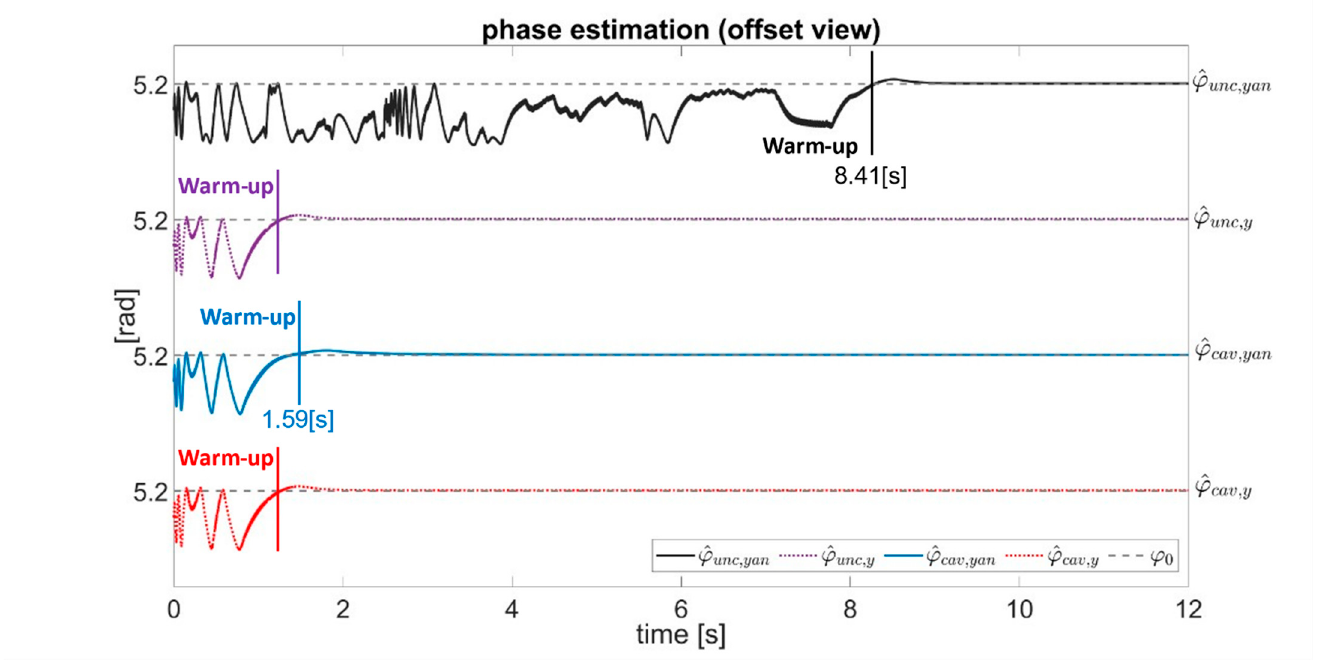
Figure 7. Offset view of phase estimation in the four simulation cases, with warm-up phase